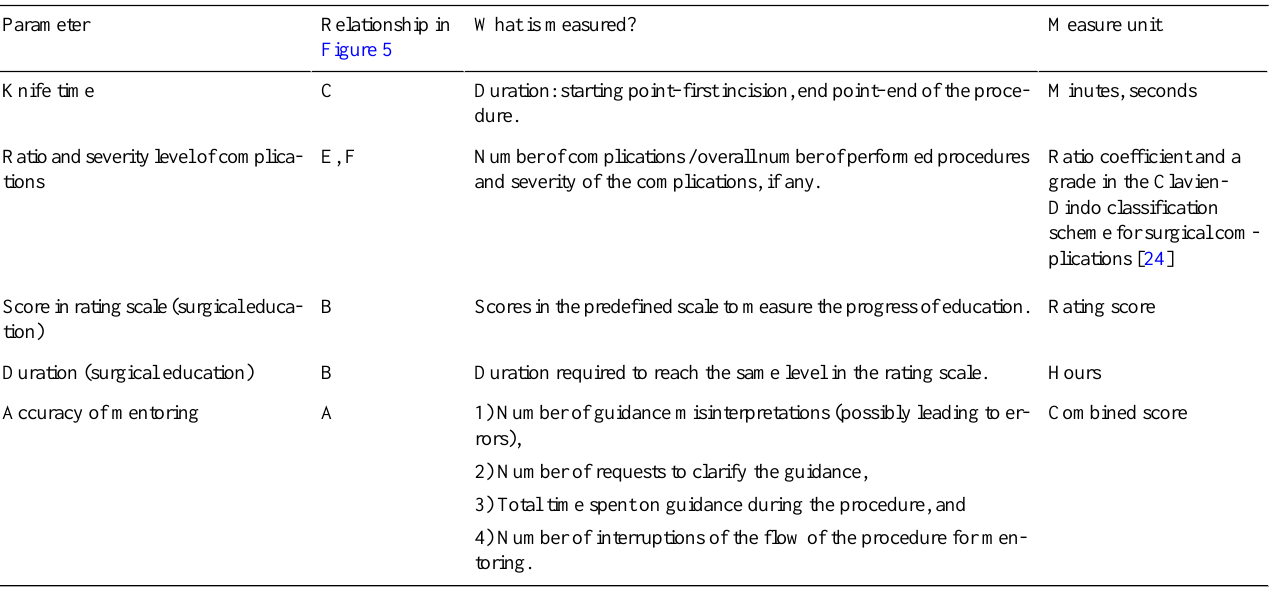
Table 1. Measurement